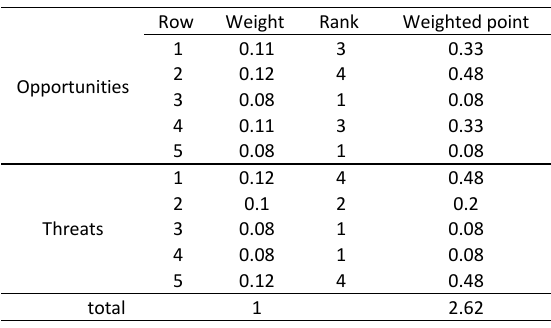
Table 9: External factors